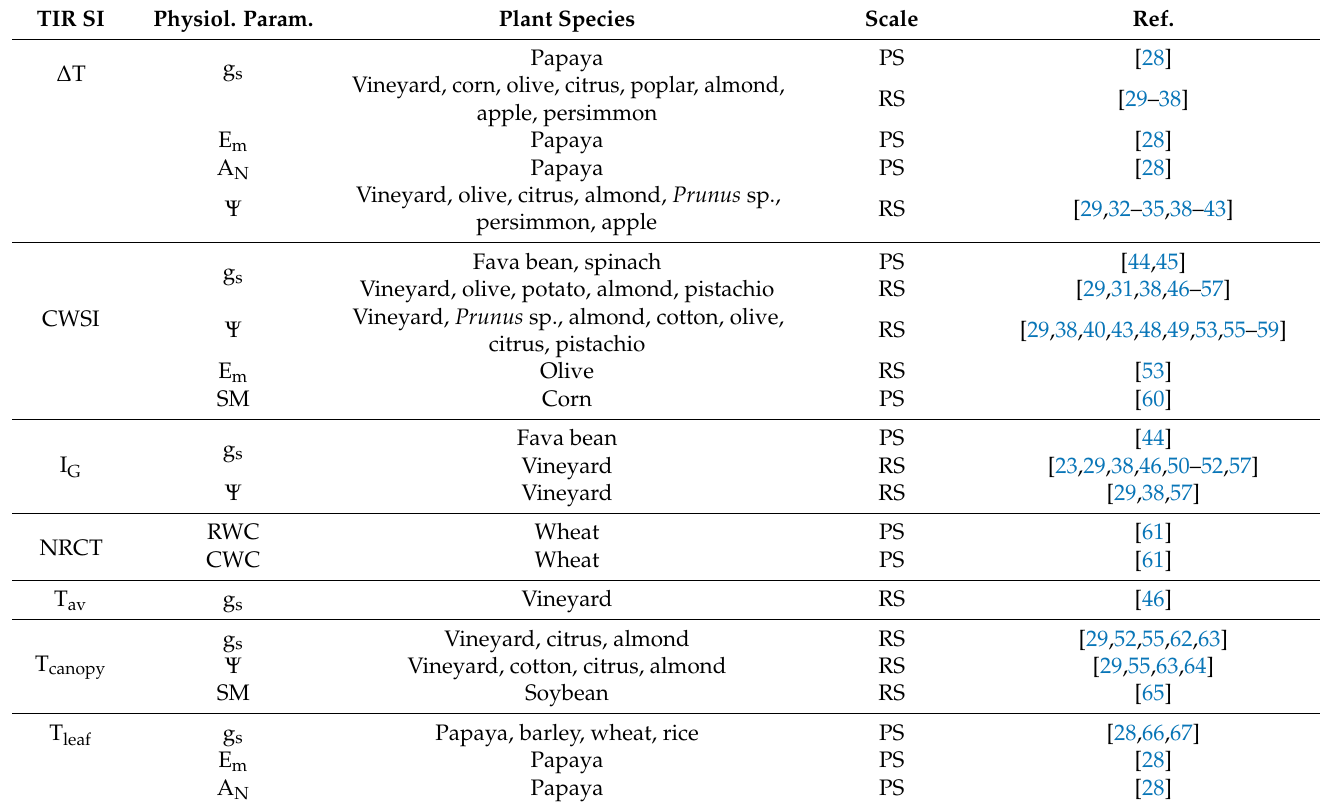
Table 2. Correlations between TIR stress indices (TIR SI) and physiological parameters (physiol. param.) applied to estimate physiological traits related to water stress or salinity at proximal (PS) and remote sensing (RS) scales. ∆ T, normalized canopy temperature; A N , net photosynthesis rate; CWC, canopy water content; CWSI, crop water stress index; E m , leaf transpiration rate; Ψ , hydric potential; gs, stomatal conductance; I G , index of stomatal conductance; NRCT, normalized relative canopy temperature; RWC, relative water content; SM, soil moisture; T av , average canopy temperature; T canopy , canopy temperature; T leaf , leaf temperature. TIR SI Physiol.